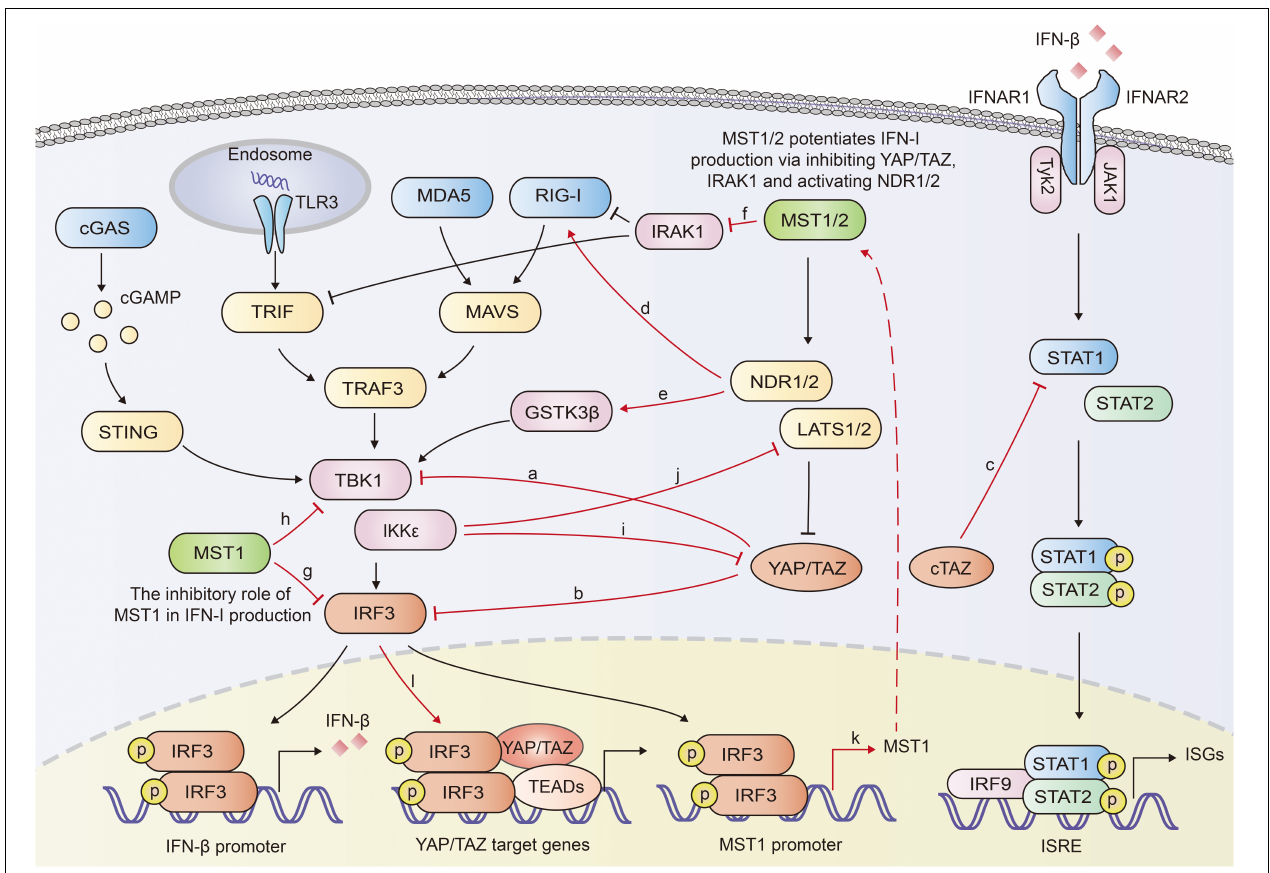
FIGURE 2 | Overview of reciprocal augment of Hippo-YAP signaling and innate antiviral response. YAP/TAZ antagonizes the innate antiviral response by inhibiting the activation of TBK1 (a) or IRF3 (b) . cTAZ inhibits STAT1 activation and ISGs production (c) . NDR2 promotes the K63-linked polyubiquitination of RIG-I, potentiating the IFN- β production (d) . NDR1 facilitates TBK1 activation by mediating the activation of GSK3 β (e) . MST1 mediates the degradation of IRAK1, a negative regulator for IFN- β production (f) . MST1 inhibits IRF3 (g) and TBK1 (h) , repressing IFN- β production. IKK ε mediates the degradation of YAP (i) and LATS1/2 (j) . Activated IRF3 induces the transcription of MST1 and the activation of Hippo pathway (k) . Activated IRF3 interacts with YAP-TEAD complex and promote the activation of YAP ( l ). In general, Hippo-YAP signaling and innate antiviral signaling exhibit reciprocal activation. The interplays between Hippo-YAP and innate antiviral signaling are highlighted with red